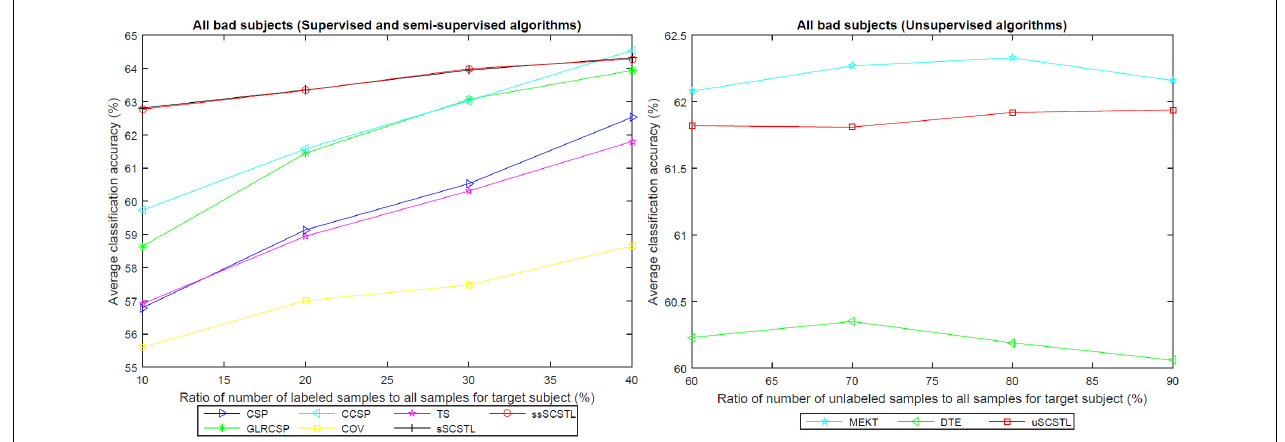
FIGURE 5 | The means of accuracies of all bad subjects on dataset MI1 for different algorithms with varying R l or R u .